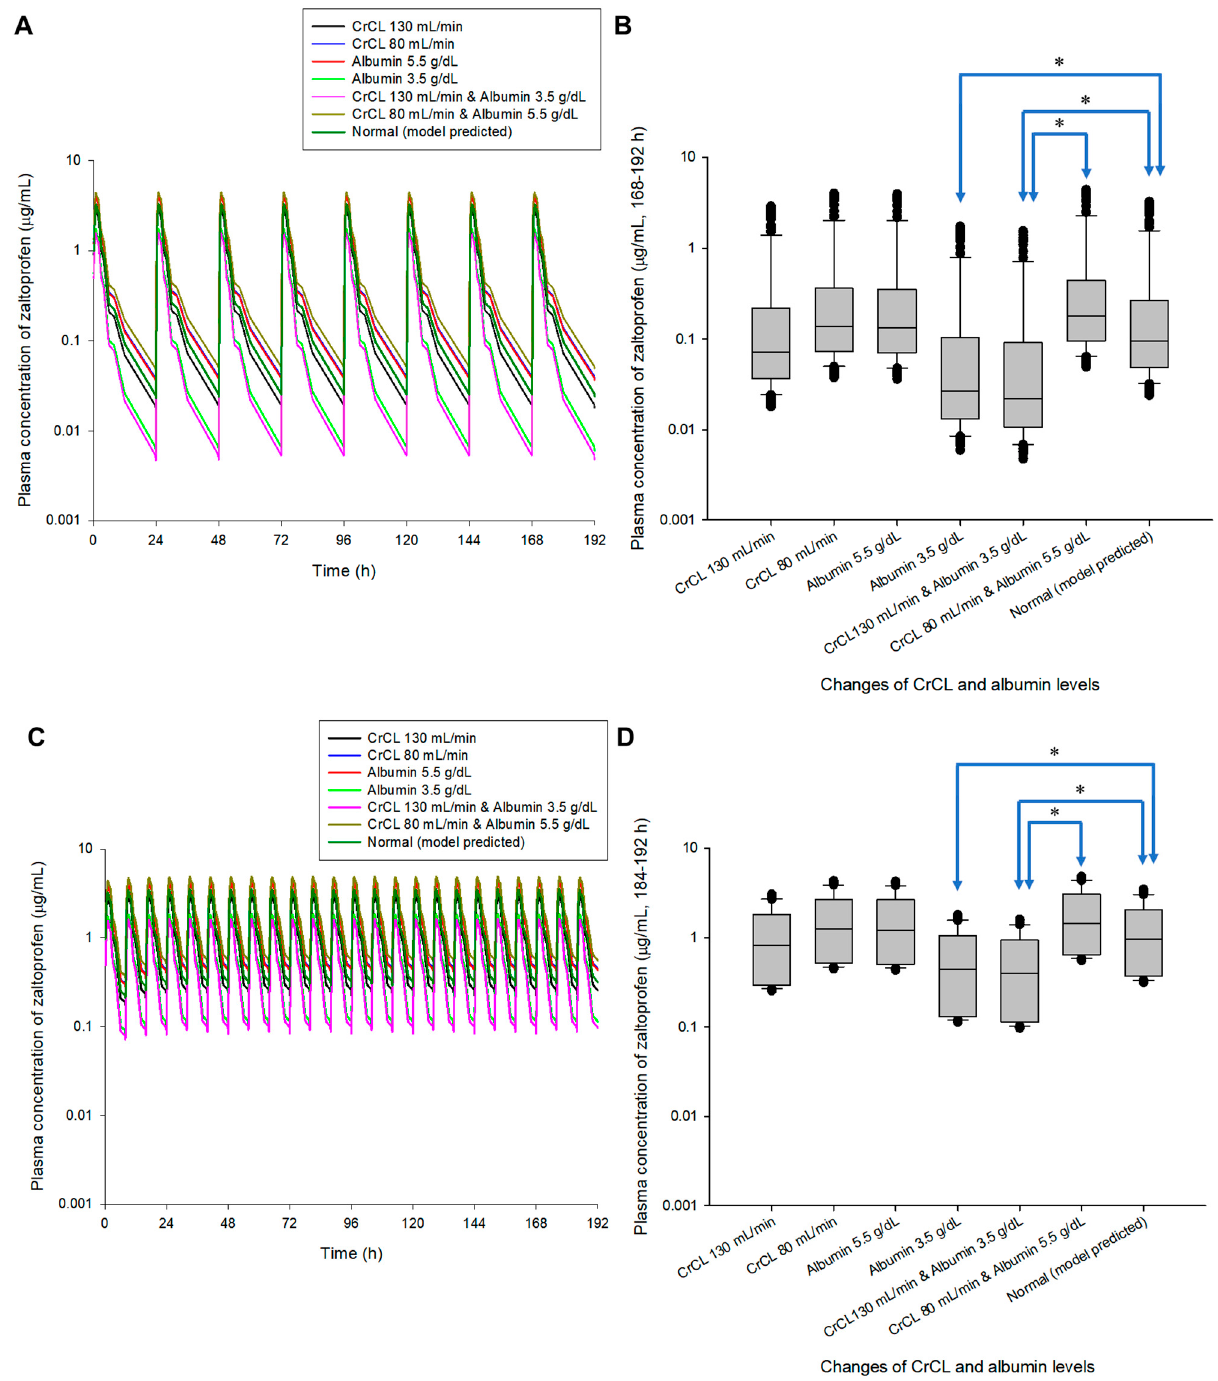
Figure 3. Simulation of pharmacokinetic prediction profiles after multiple (24 h ( A , B ) and 8 h intervals ( C , D )) oral administrations of zaltoprofen (80 mg) according to the change in CrCL and albumin levels. The lines in the graph ( A , C ) indicate the mean values corresponding to 50% of each group. Normal in the graph is the 50% average predicted by the model established in this study (based on the group with median values of CrCL and albumin of 104.38 mL/min and 4.90 g/dL, respectively). A comparison ( B , D ) of predicted intergroup plasma concentrations at steady-state (168–192 h ( B ) and 184–192 h ( C )) following changes in CrCL and albumin levels. * indicates a statistically significant difference between groups with p < 0.05.